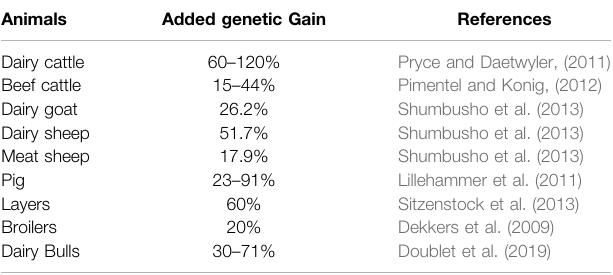
TABLE 1 | Impact of genomic selection a .